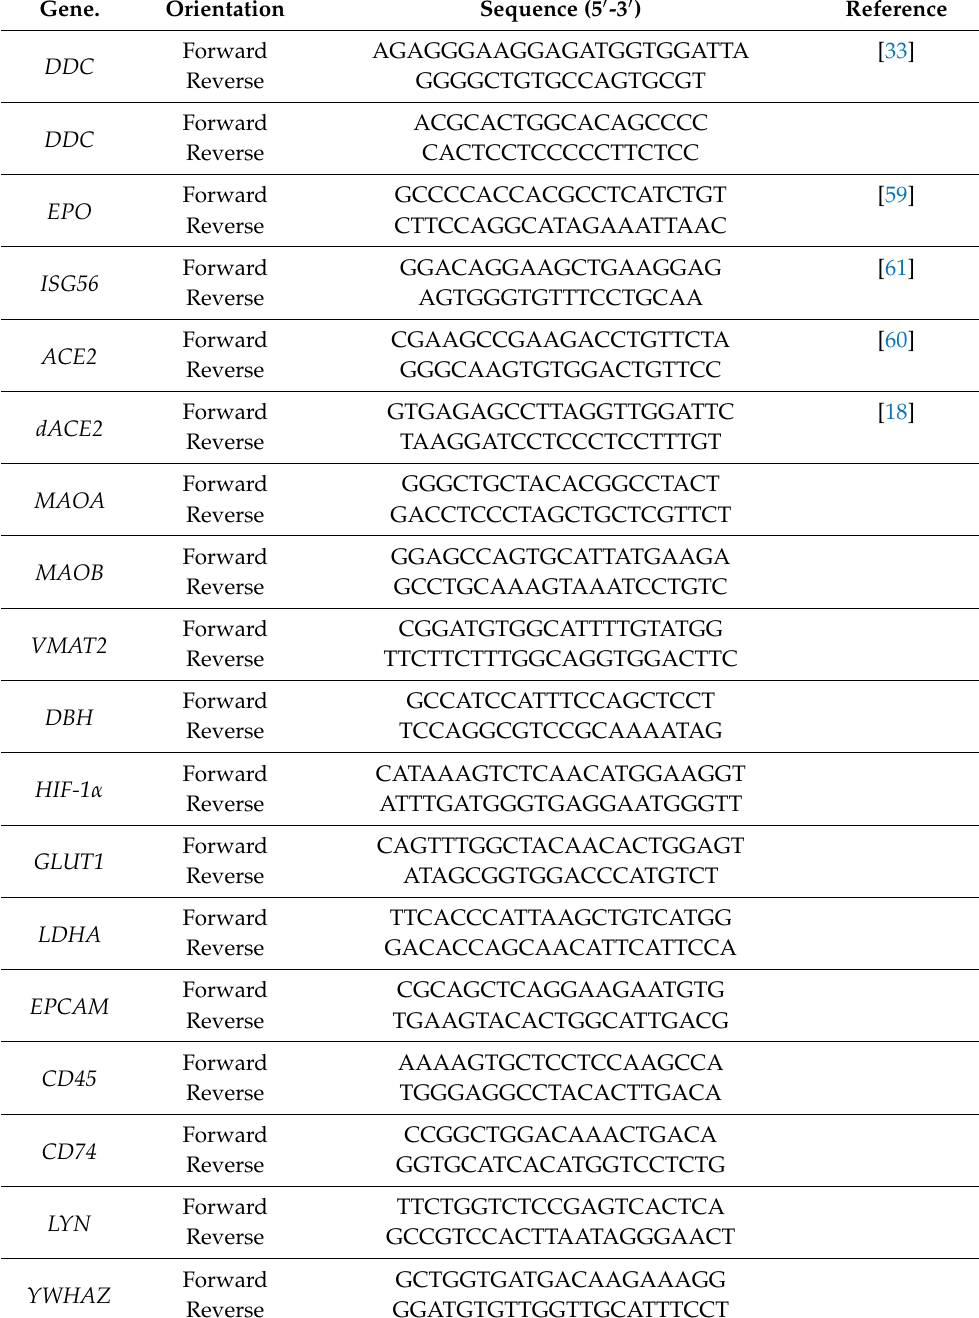
Table 1. Priming oligonucleotides used in the RT-qPCR analysis.